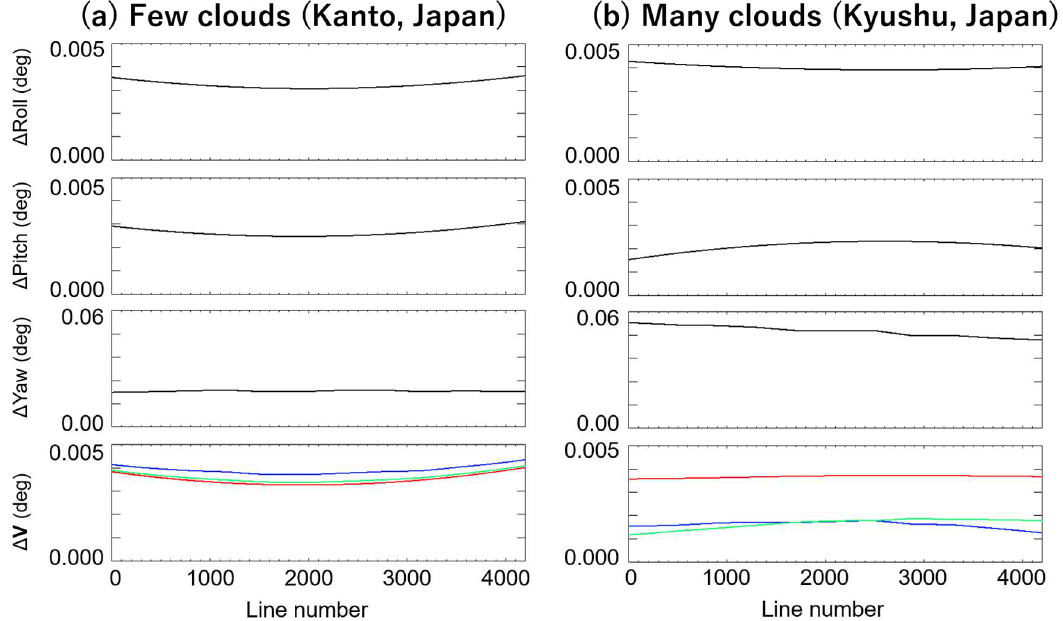
Figure 7. Differences of roll, pitch and yaw angles between two attitudes derived from onboard attitude sensors of Terra/ASTER and proposed method in ( a ) few clouds and ( b ) many clouds. Bottom panels show differences in directions of line-of-sight vectors between two attitudes at center (red line), left edge (green), and right edge (blue lines) of ASTER in each line.